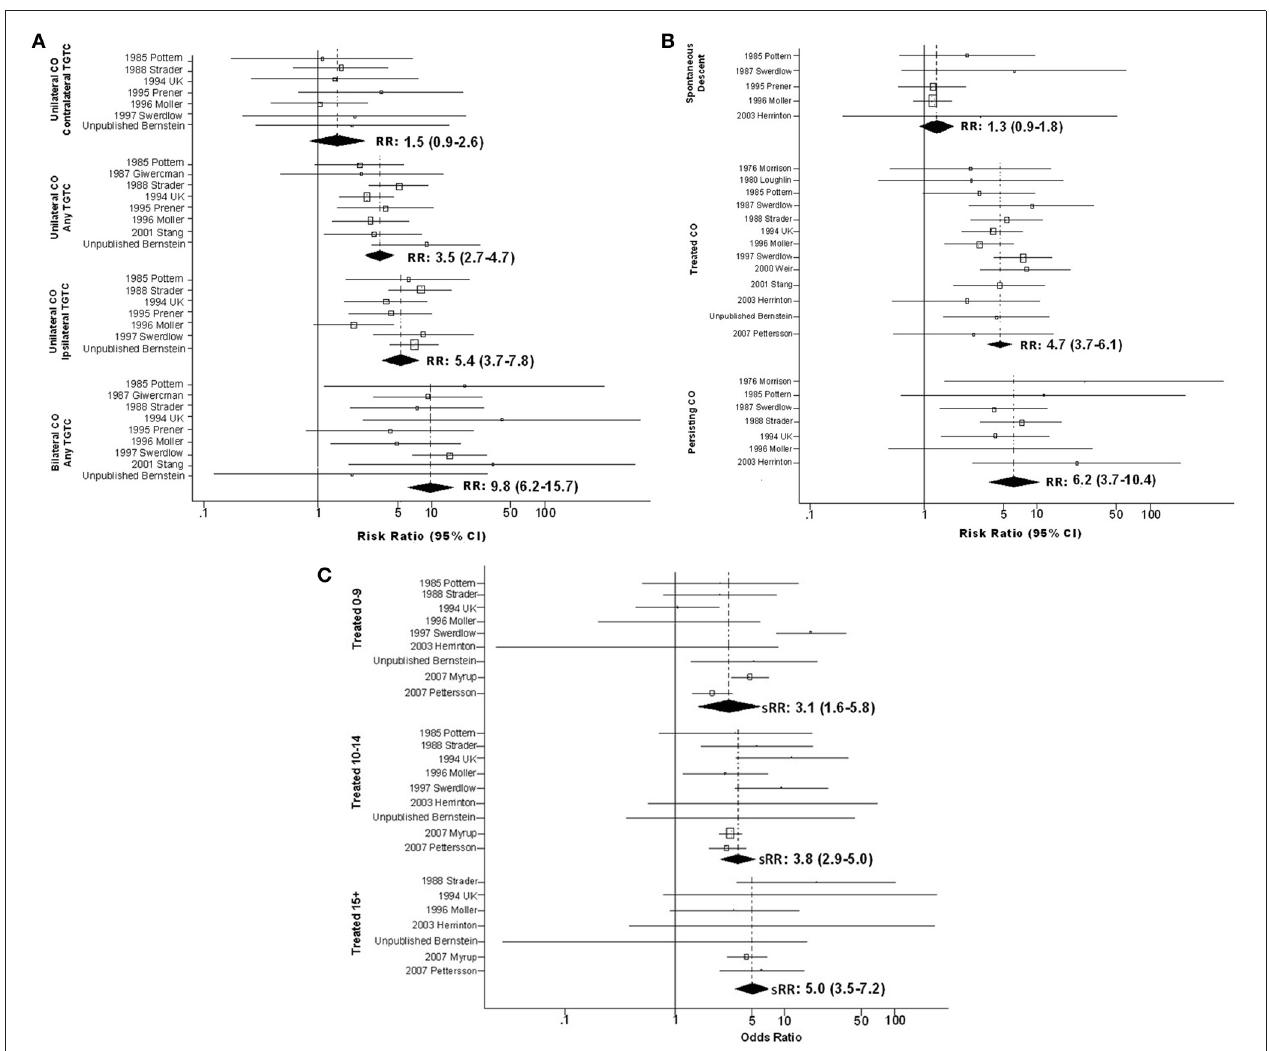
FIGURE 2 | Forest plots of relative risk estimates relating cryptorchidism to risk of TGCT, stratified by features of cryptorchidism; (A) By laterality of cryptorchidism relative to tumor; (B) By method whereby cryptorchidism was resolved; (C) By age at treatment for